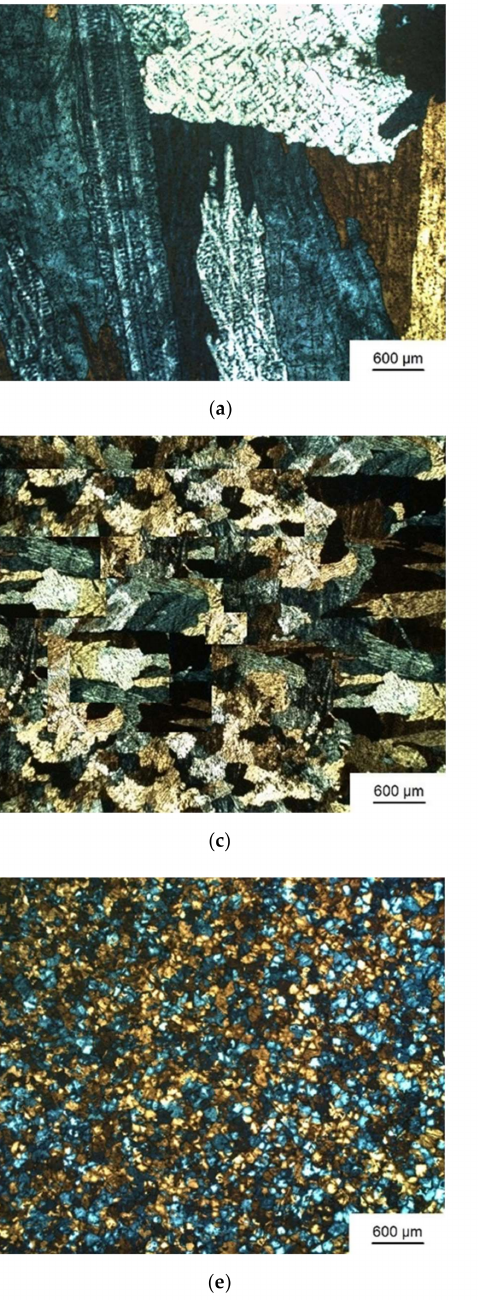
Figure 2. Optical microstructure Al 0.3 Mg 1 Si—( a ) steel chill mold; ( b ) copper chill mold; ( c ) copper chill mold of round section; Al 0.3 Mg 1 Si 0.3 Sc 0.15 Zr–( d ) steel chill mold; ( e ) copper chill mold; ( f ) copper chill mold of round